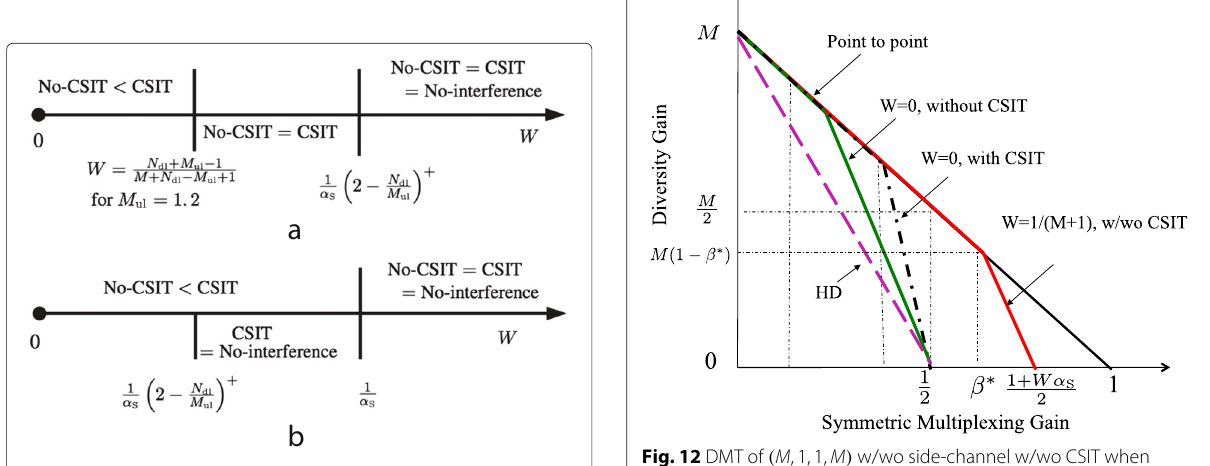
Fig. 11 Comparison of the three systems in DMT as a function of the side-channel bandwidth. a N dl ≥ M ul b M ul > N dl